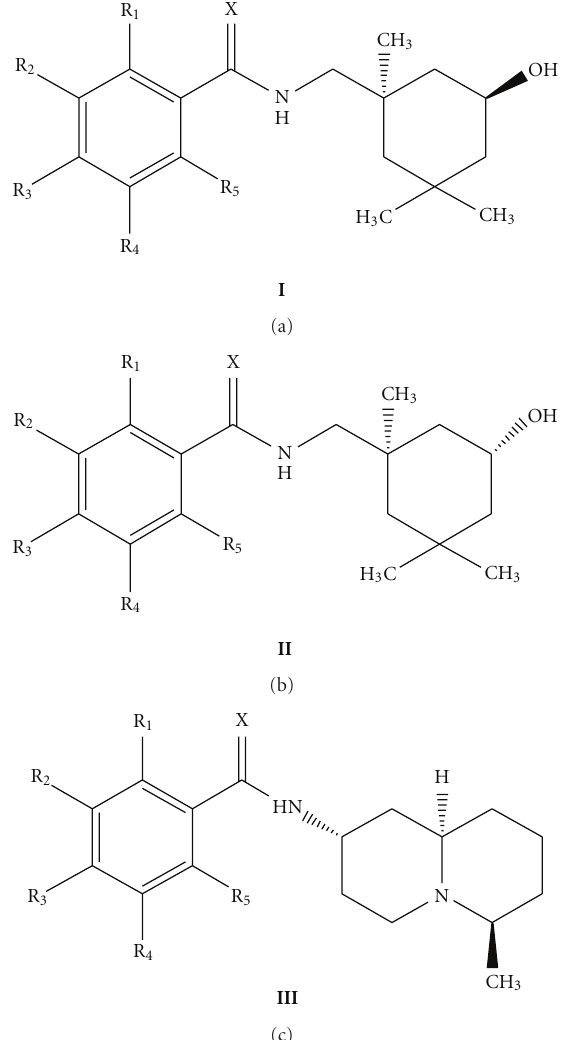
Figure 1: Common molecular skeletons.